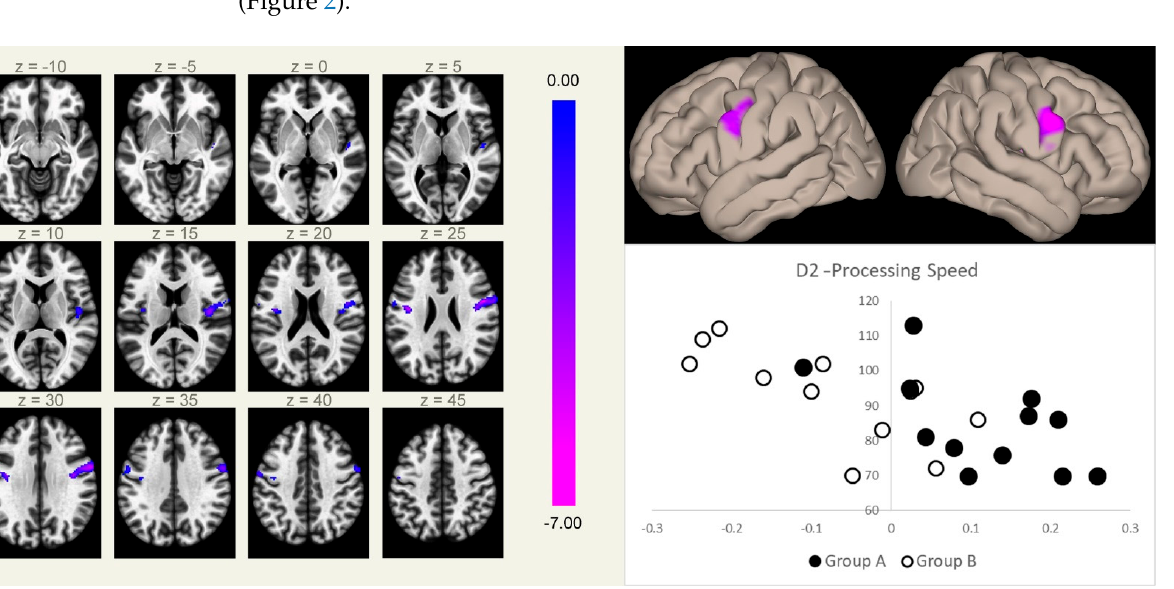
Figure 2. Connectivity between the MPFC and the right (5.9 cm 3 , MNI coordinates [+50 +02 +26]) and left (2.3 cm 3 , MNI coordinates [ − 40 − 08 +24]) rolandic opercular cortices (a region normally devoid of physiological correlation with the MPFC) correlated inversely with the speed of processing scores at the d2-R test, independent of the group membership. Clusters of significant inverse correlation are shown overlaid on the axial images from a standard T1-weighted volume in the MNI space (left, in neurological convention, MNI Z coordinates are reported for each slice), and projected onto its surface (right, upper panel). The color scale represents T-values from the GLM. In the lower right box, the processing speed scores (Y-axis) are plotted against the mean Fischer-normalized correlation coefficients of the significant clusters (X-axis) for both groups (Group A, filled marks; Group B, empty marks).